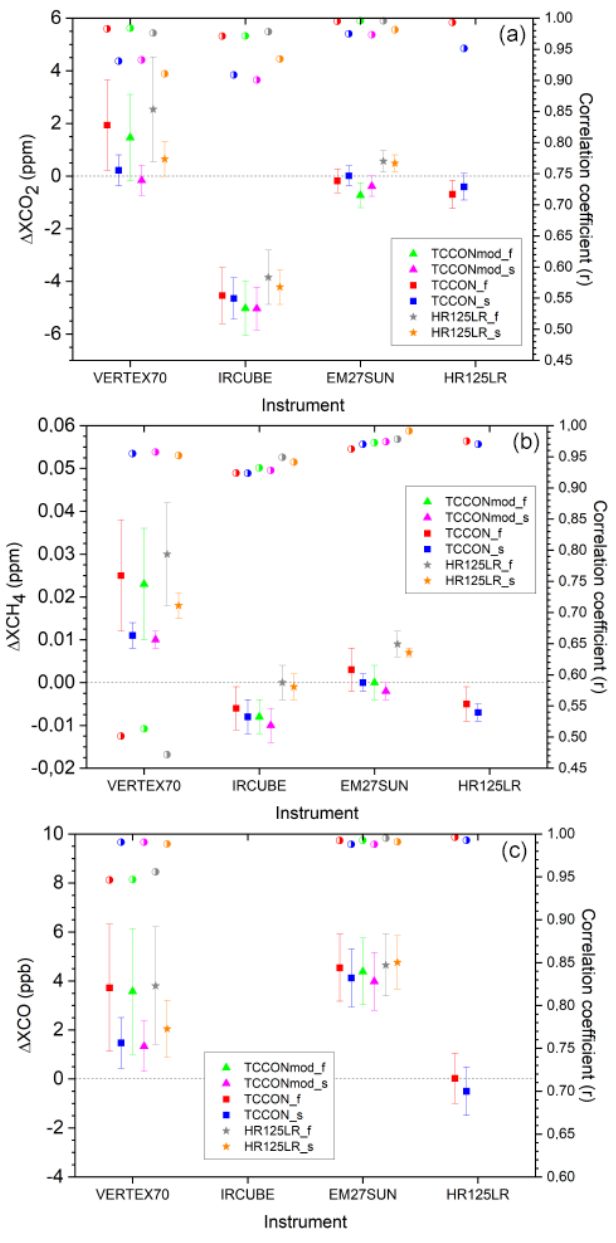
Figure 11. (a) XCO 2 bias plotted for each instrument relative to non-linearity-corrected TCCON (full year – green triangle, short period – magenta triangle), relative to TCCON (full year – red box, short period – blue box), and relative to HR125LR (full year – grey star, short period – orange star). The correlation coefficients for the respective data set are plotted as half-filled circles and correspond to the right-hand y axis. The XCH 4 and XCO biases for each in- strument are plotted in panels (b) and (c) , respectively. A horizontal dashed line at zero is overlaid on each plot to help in the interpreta- tion of the